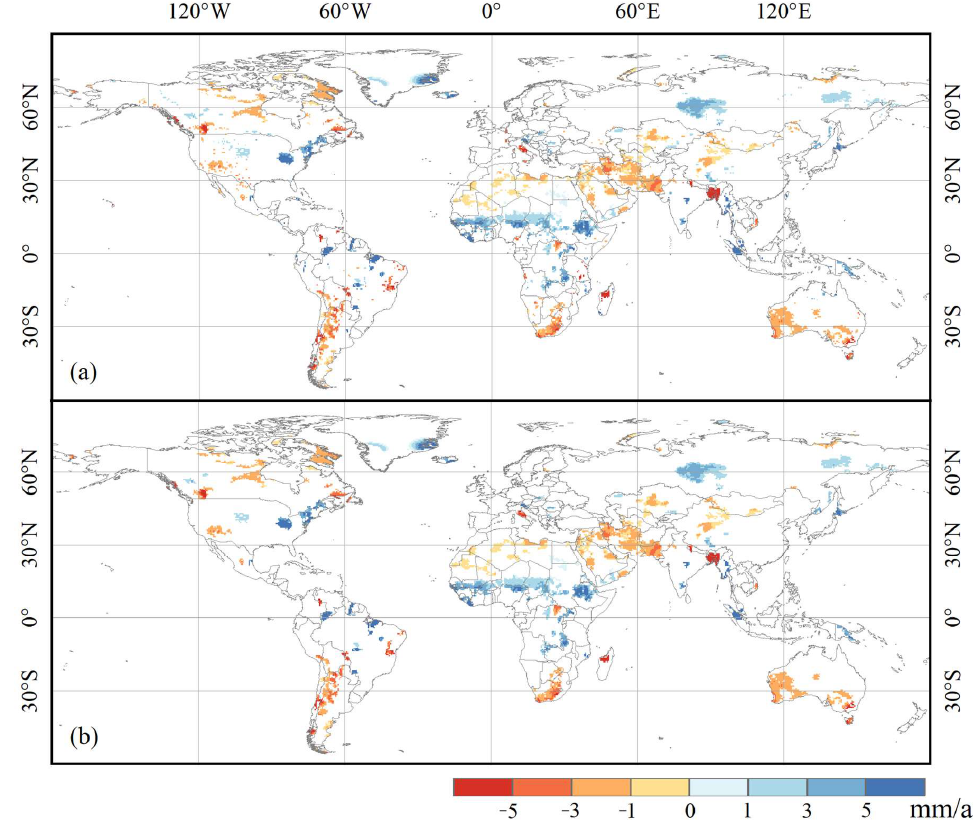
Figure 4. Geographic distribution of significant trends in annual terrestrial water yield during 1981 − 2018, using the Mann-Kendal trend test, ( a ) before and ( b ) after correcting for multiple hypothesis testing. Shades of blue (red) indicate a significant increasing (decreasing) trend at α = 0.05. Grid cells with no statistical significance are shown in white.